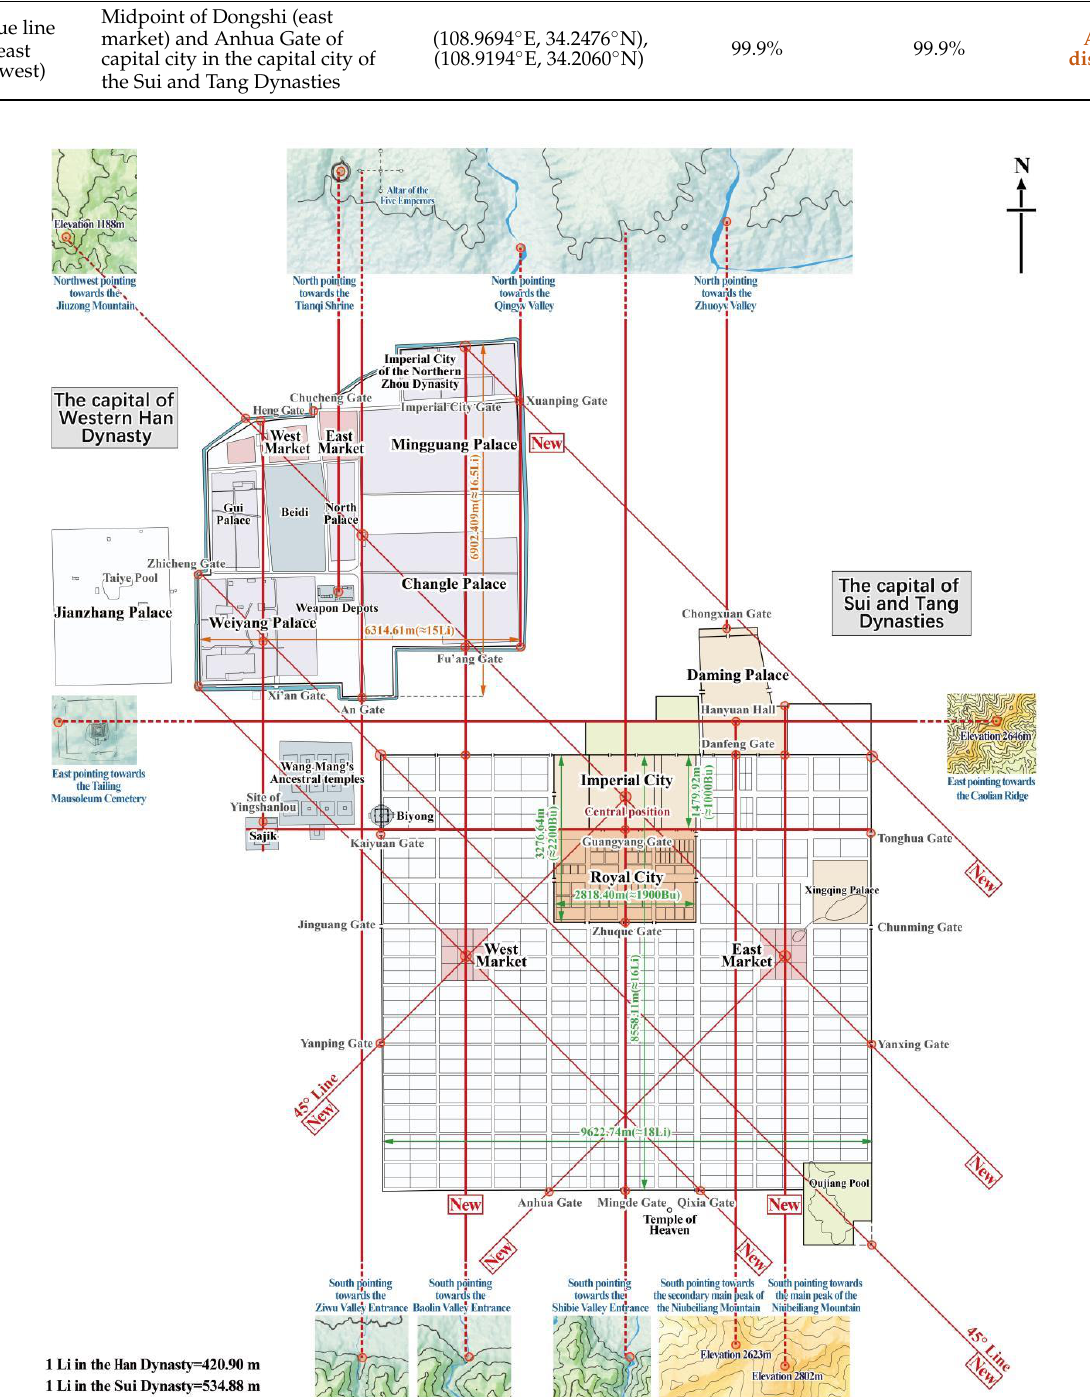
Figure 8. Analysis of the alignment relationship between the capitals of the Western Han dynasty as well as the Sui and Tang